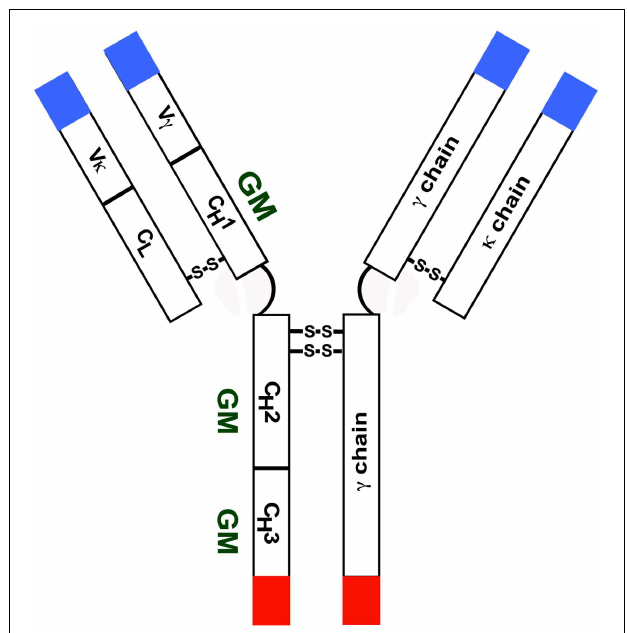
FIGURE 1 | Diagrammatic representation of an IgG molecule with a κ light chain . Most GM alleles are expressed in the CH2 and CH3